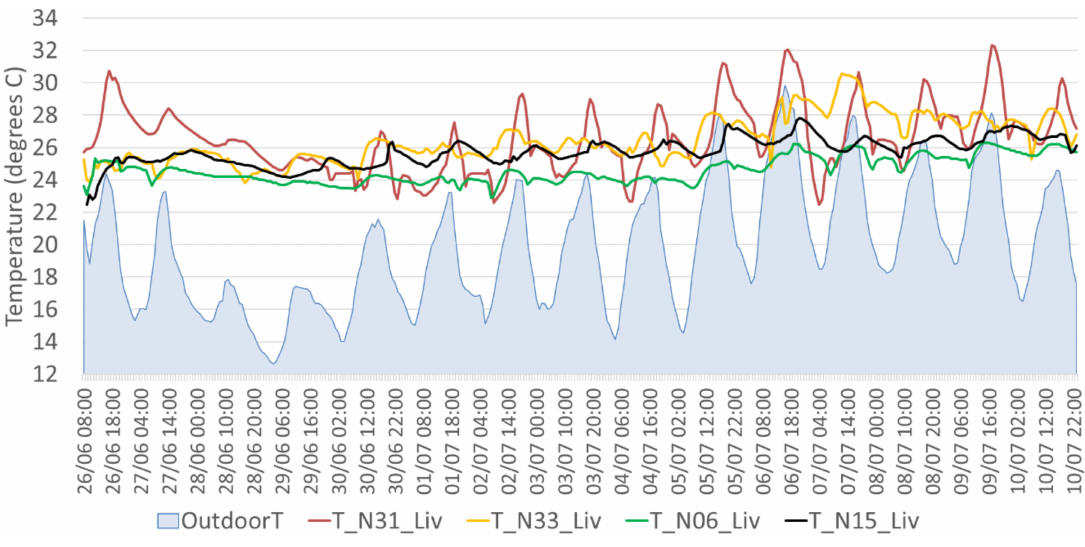
Figure 6. Living room temperatures during period of maximums (26 June–10 July 2017). Table 6. Summary characteristics of flats and monitored rooms.